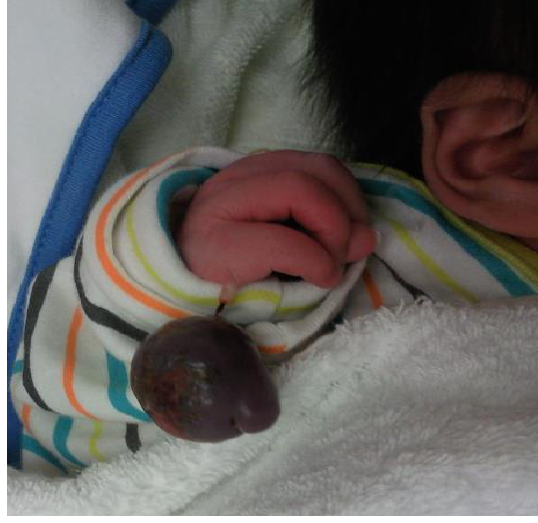
Figure 1: Angiomyxoma of extra